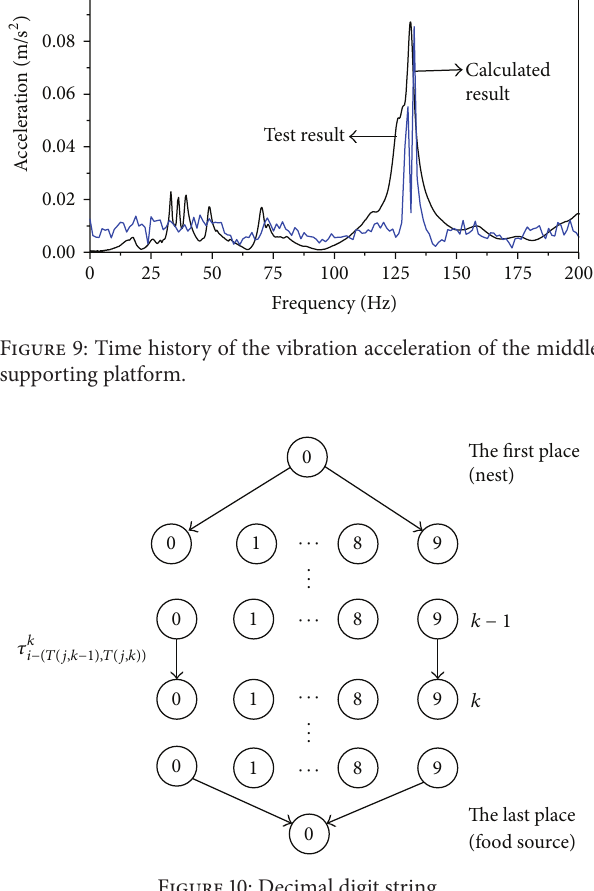
Figure 10: Decimal digit